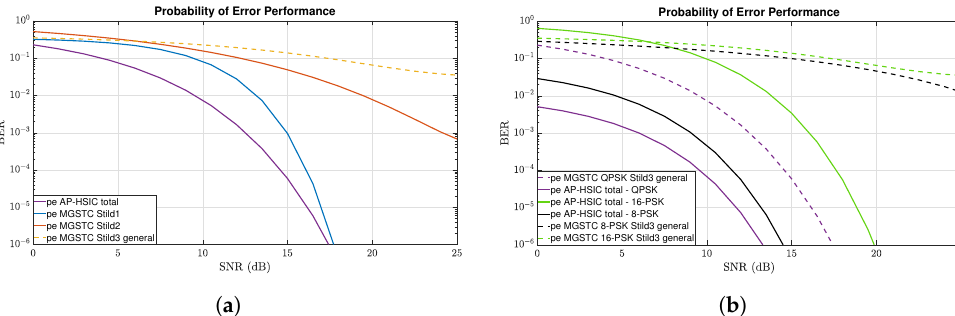
Figure 5. BER vs. SNR of MGSTC and AP-HSIC. ( a ) Comparison under 16-PSK in the presence of high- leveled AWGN. ( b ) Comparisons using QPSK, 8-PSK,16-PSK, in the presence of high-level